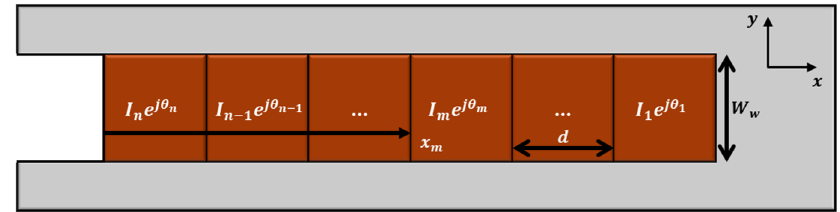
Figure 5. Slot geometry used in the 1D analytical model.